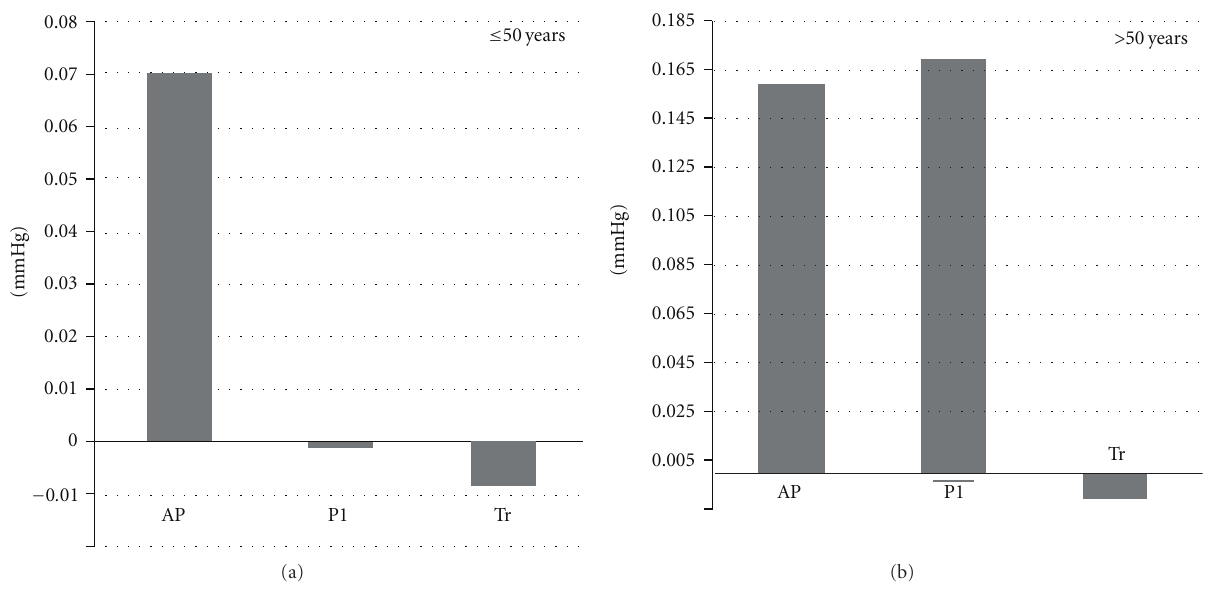
Figure 2: Per year contribution on augmented pressure (AP), incident pressure (P1), and round trip travel time younger and older subjects.